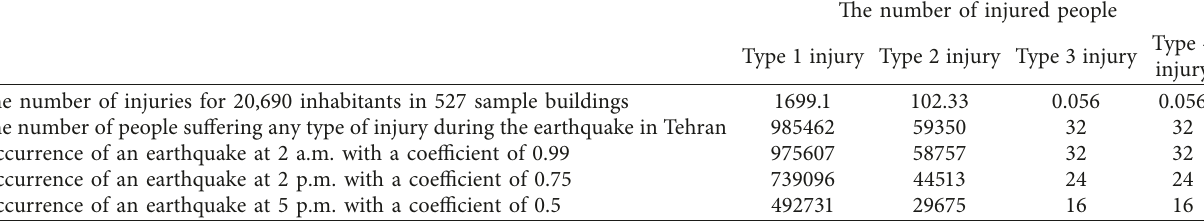
Table 5: The number of people injured in Tehran during the earthquake.